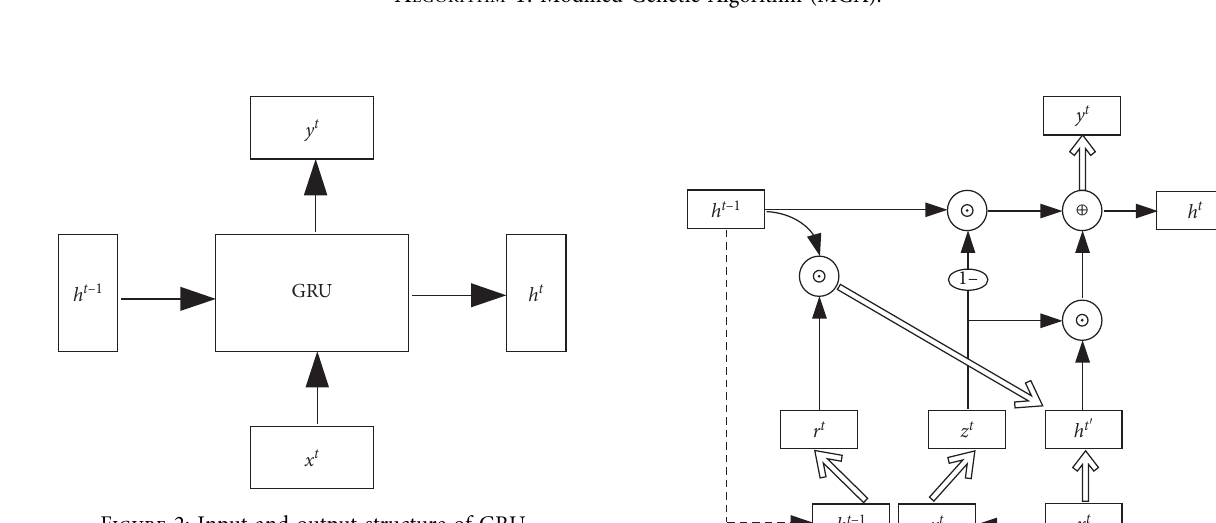
A LGORITHM 1: Modified Genetic Algorithm (MGA).